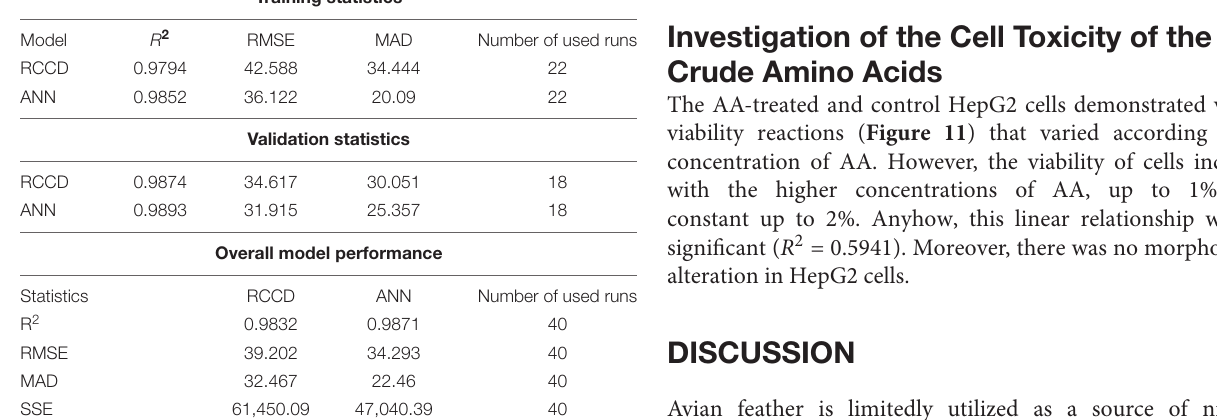
Frontiers in Microbiology |